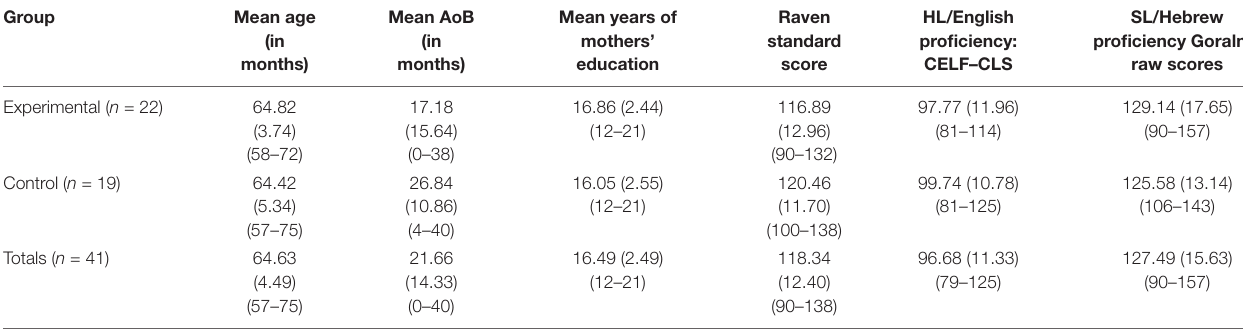
TABLE 1 | Background information for